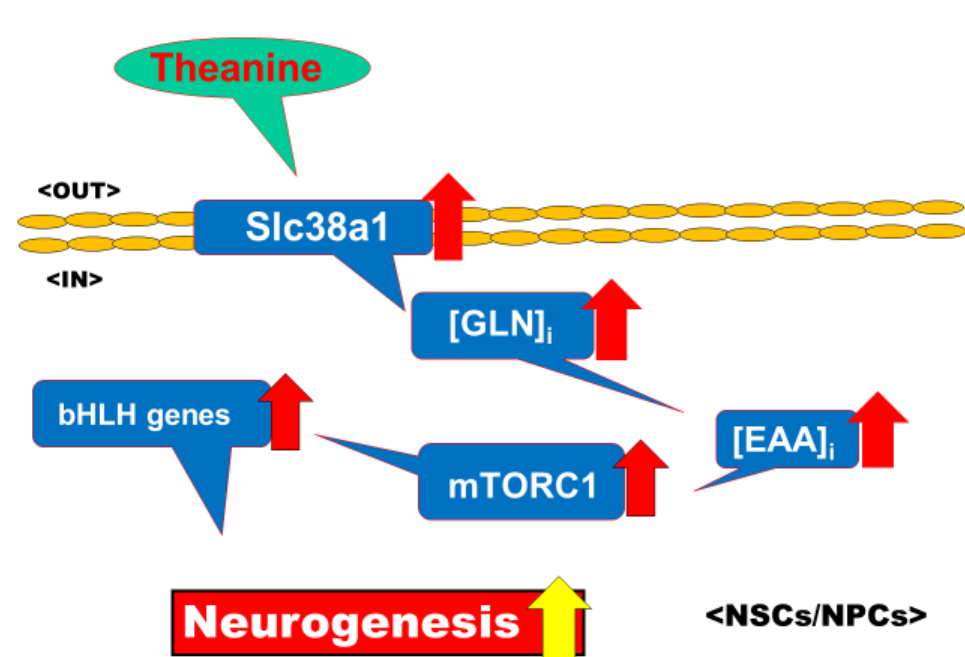
Figure 1. Proposed signaling from theanine to neurogenesis. Sustained exposure to theanine selectively up-regulates the expression of an isoform of glutamine transporter (GLNT), Slc38a1, among di ff erent adherent and trophic molecules endowed to modulate the properties of neural stem cells (NSCs) toward an increase in the intracellular glutamine (GLN) level in primitive NSCs / neural progenitor cells (NPCs) only, but not in daughter cells such as neurons and astrocytes. In exchange of intracellular GLN, the incorporation of extracellular essential amino acids (EAAs) is facilitated to activate mTORC1 phosphorylation signaling to upregulation of several basic helix-loop-helix (bHLH) transcription factors capable of promoting neurogenesis in NSCs / NPCs. In neurons and astrocytes, by contrast, theanine is unable to up-regulate the expression of Slc38a1, which is absolutely required for triggering the proposed signaling